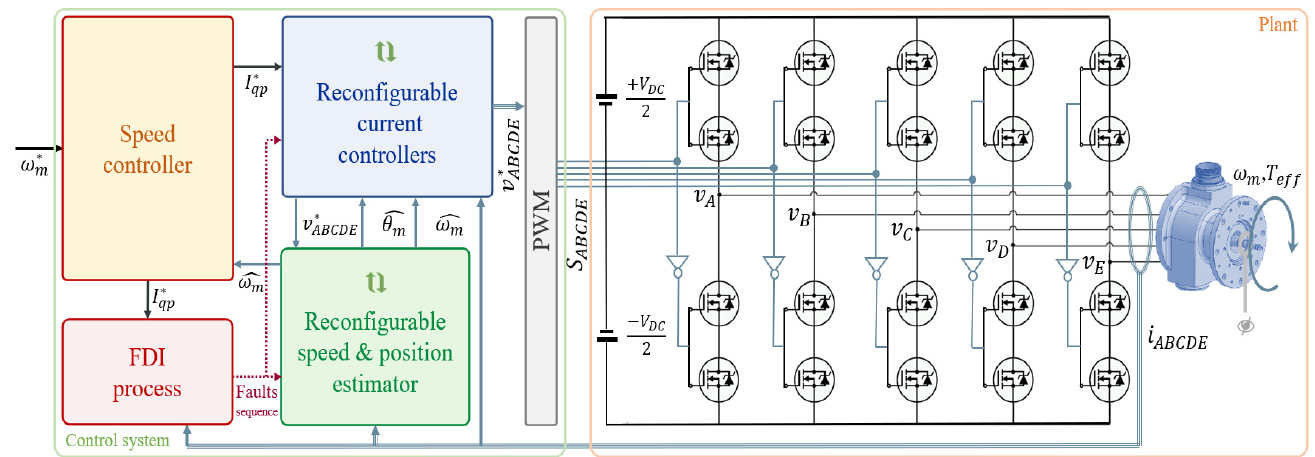
Figure 1. Structure of the developed five-phase PMSM drive system.